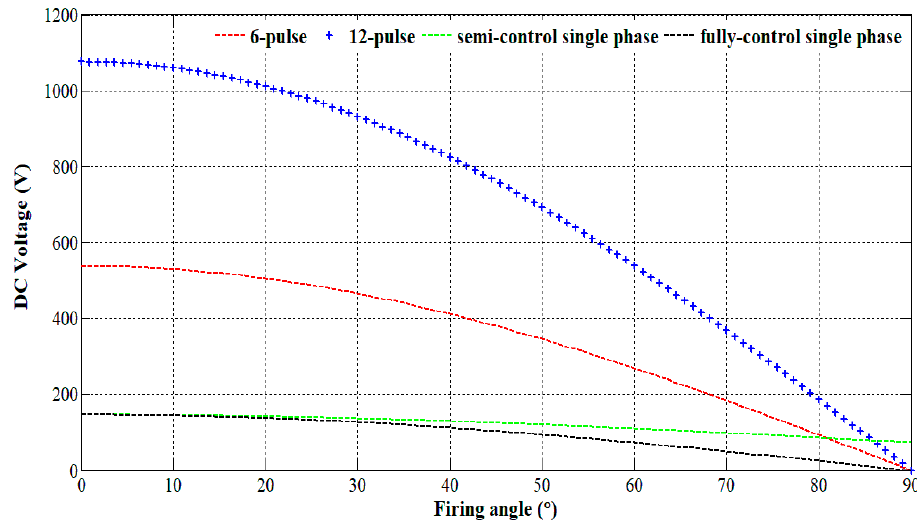
Figure 16. Comparison of the output DC voltage according to the firing angle.